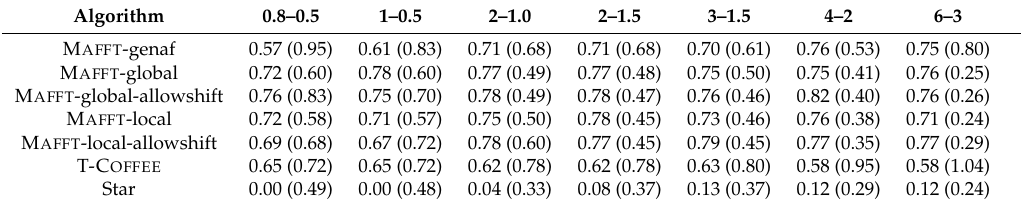
Table 4. p values of the Wilcoxon signed-rank tests for pairs of algorithms with regard to the